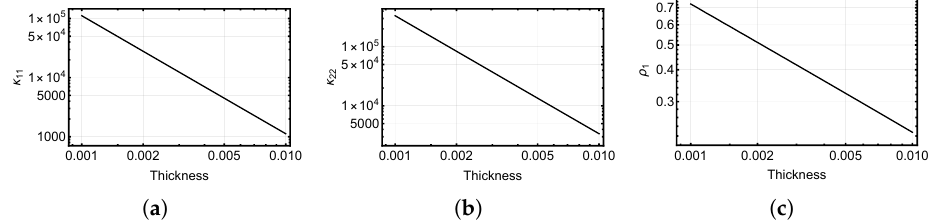
Figure 13. Free boundary. Notice, that ρ 1 is diverging, however, with a very small constant. This indicates that the boundary layer resolution is not accurate enough to conform to Kirchhoff–Love condition. The aggregate parameter-dependence is correct, the bending terms dominate the en- ergy completely. ( a ) κ 11 ( u ) ∼ 1/ t 2 . ( b ) κ 22 ( u ) ∼ 1/ t 2 . ( c ) ρ 1 ( u ) ∼ 1/